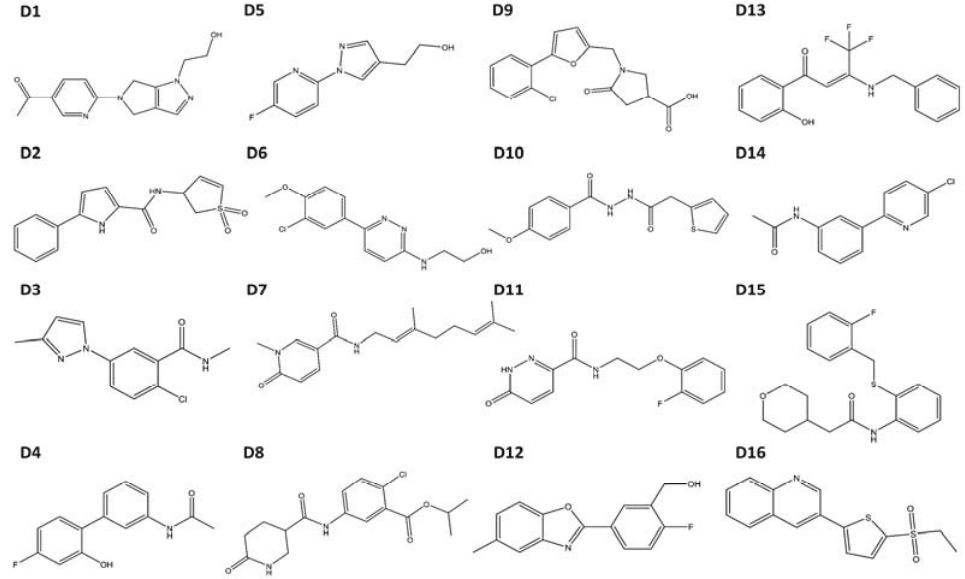
Figure 5. AHR target gene induction of Compounds D1 – D16 . ( A ) Quantitative RT-PCR